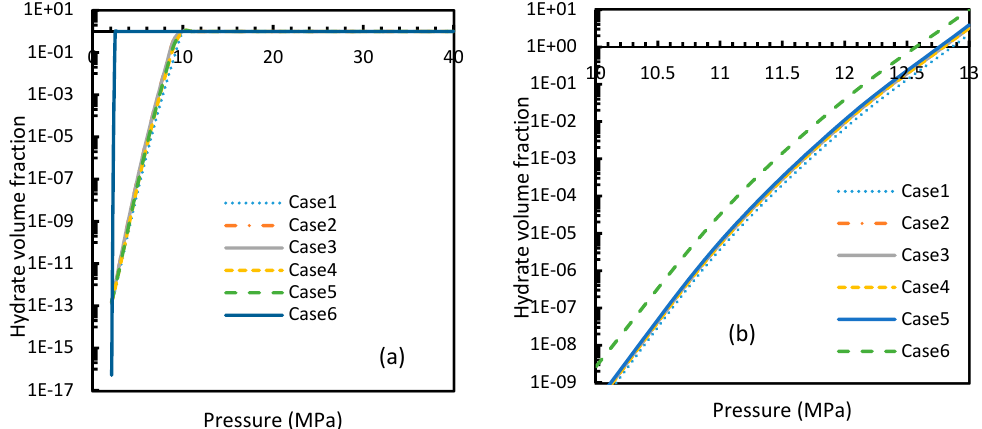
1E-171E-151E-131E-111E-091E-07